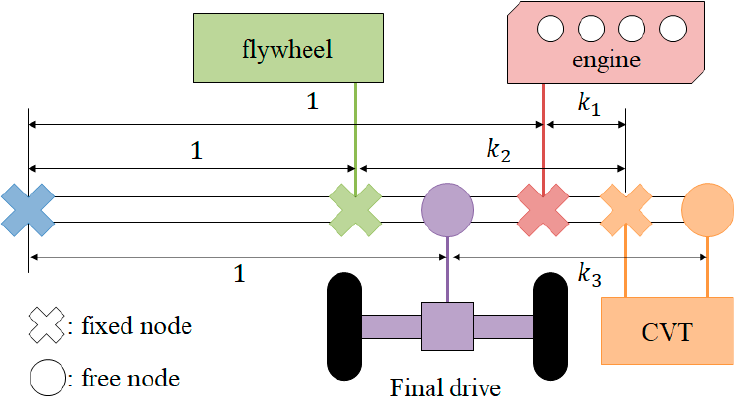
Figure 4. Single lever expression of the PS-FHV.